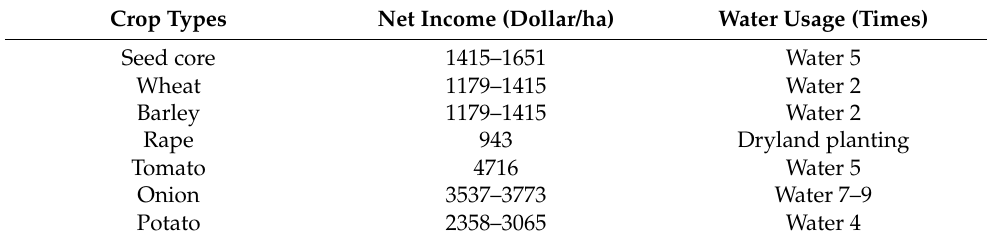
Table 9. Per hectare net income and water use of different crops in Zhangye City.